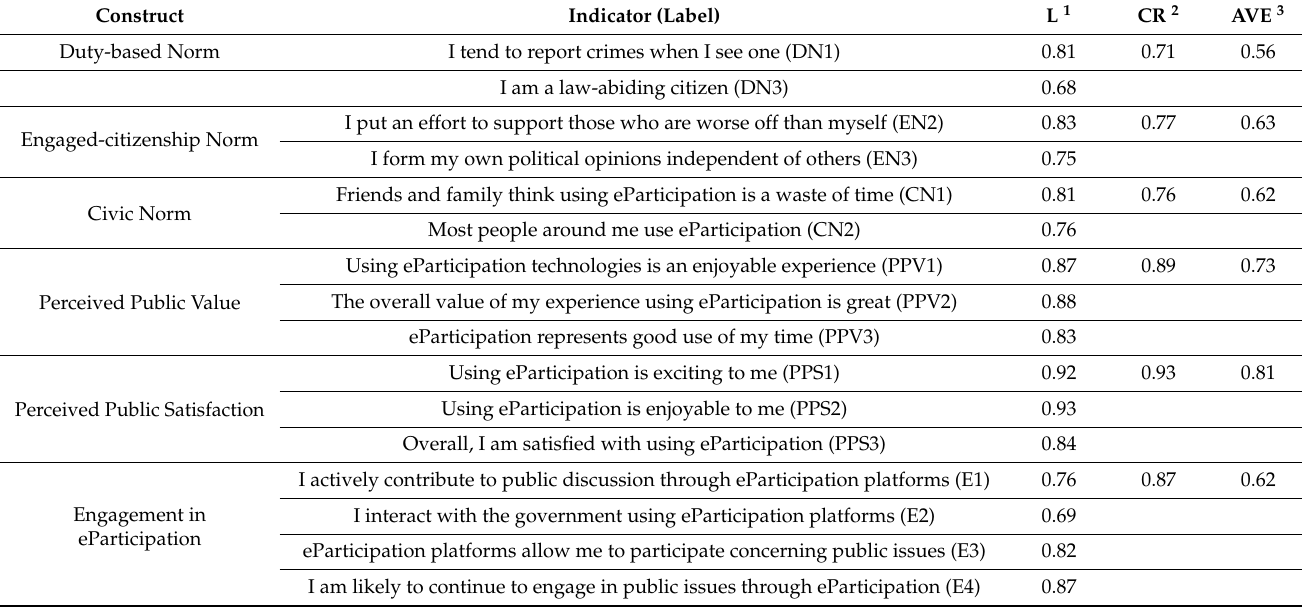
Table 3. Measurement model